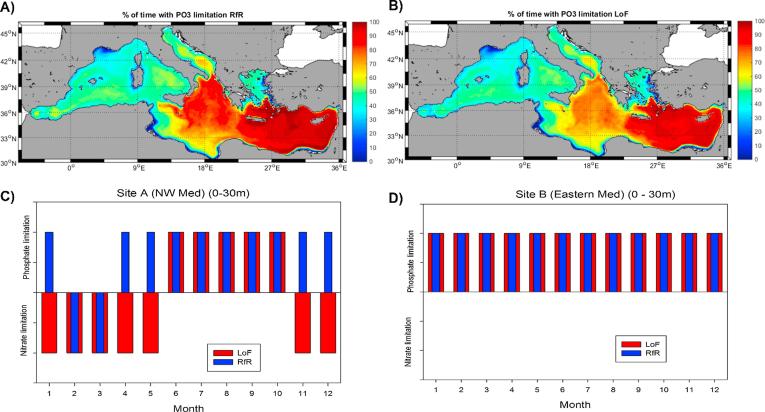
(A) Map of the percentage of time with phosphate limitation for the RfR simulation. (B) Map of the percentage of time with phosphate limitation for the LoF simulation. (C) Climatological seasonal cycle of nutrient limitation at site A (see Fig. 1) for RfR (blue bars) and LoF (red bars). D) as panel C) but for site B (see Fig. 1). (For interpretation of the references to color in this figure legend, the reader is referred to the web version of this article.)